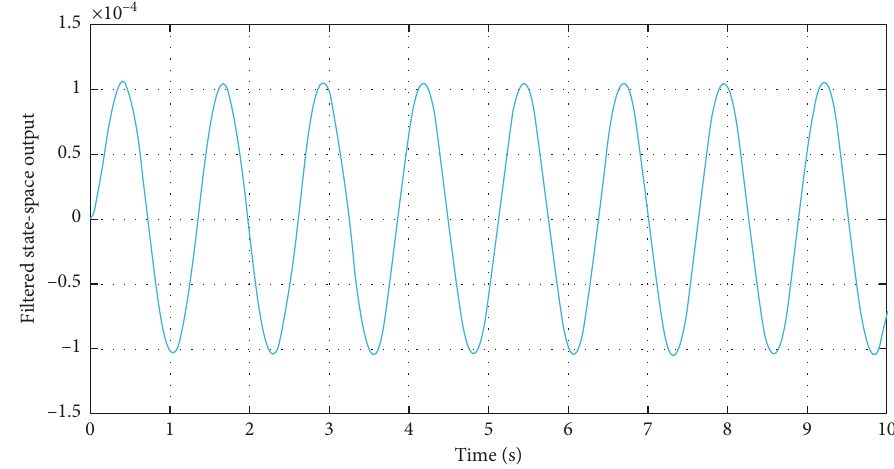
Figure 21: Filtered beam deflection at sensor location ( w ( x